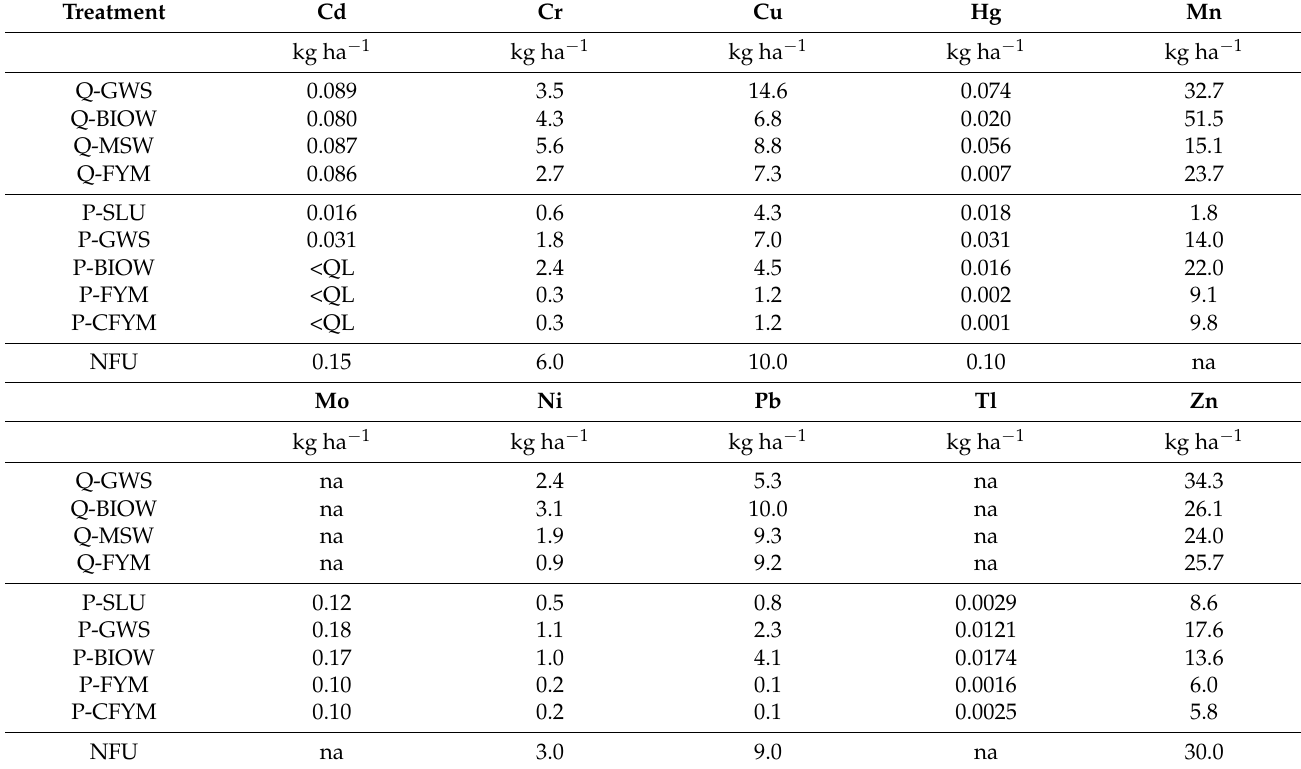
Table 3. Cumulated flux of trace elements in 10 years of spreading by organic waste products (kg ha − 1 ) as compared to the French regulation level (NFU) [10,11], with the following data presented: See Figures 1 and 2 for treatments signification. For values inferior to the quantification limit (QL) the QL divided by 2 were considered to calculate fluxes, <QL: at least half of values were lower than the QL. na for not available.